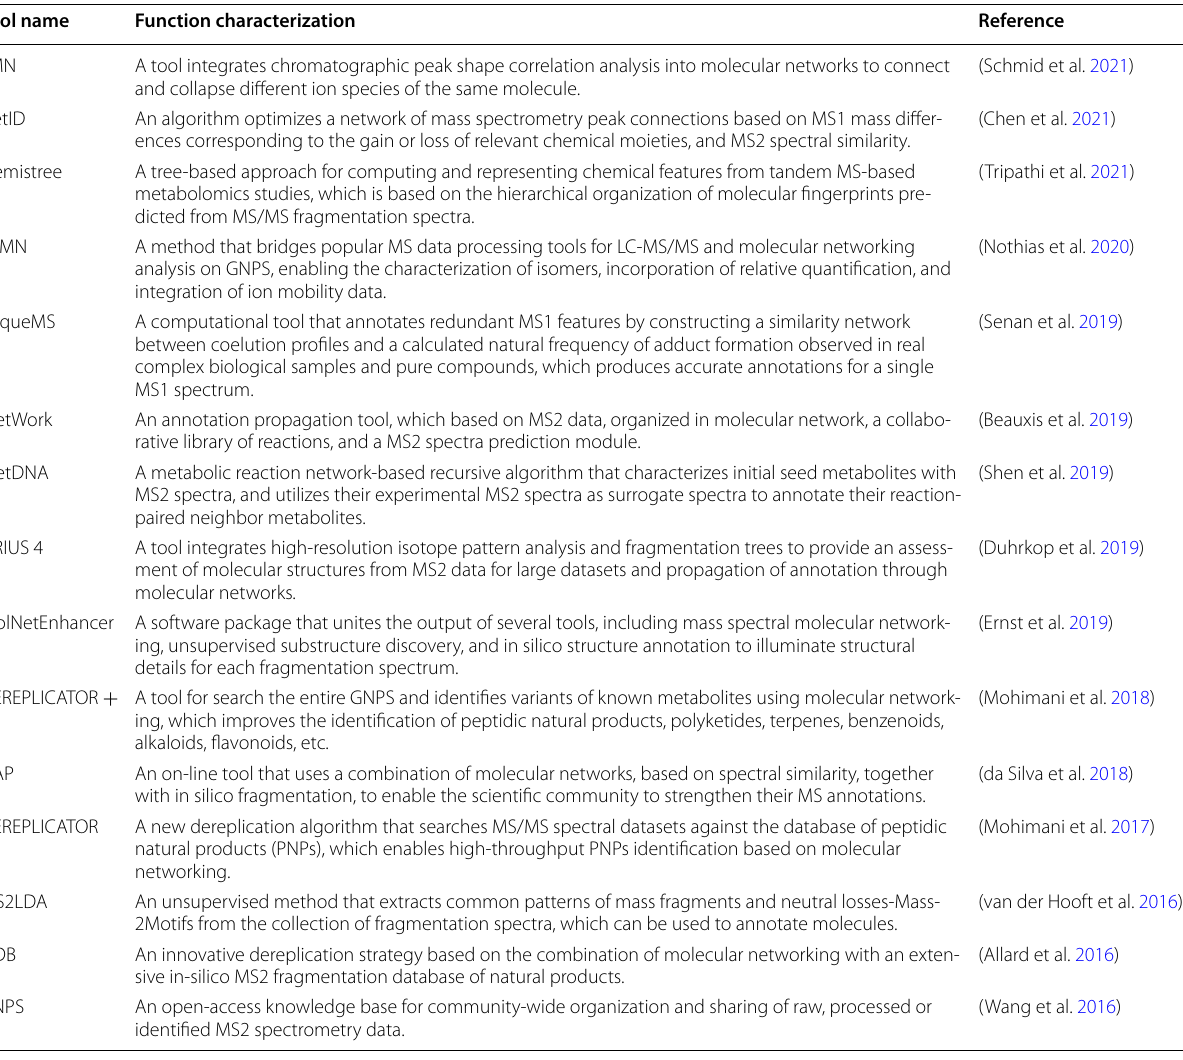
Table 2 Advanced molecular networking tools for metabolite annotation of LC-MS/MS